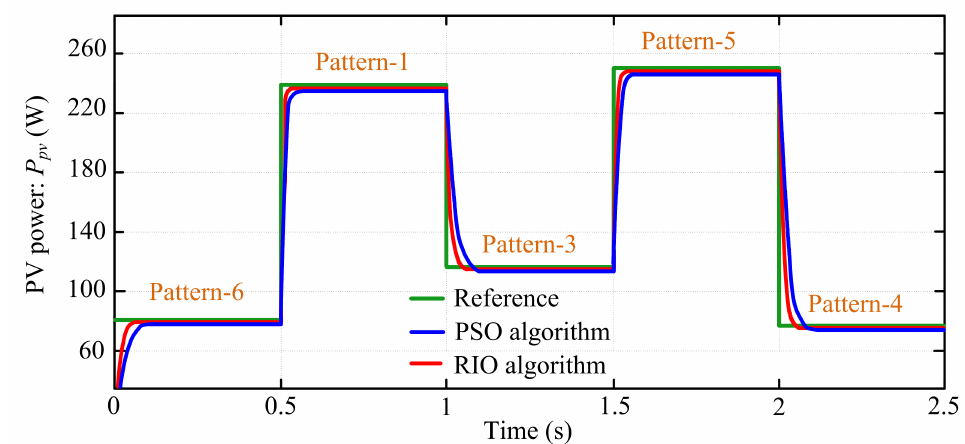
Figure 12. Output power performance graph of the PV